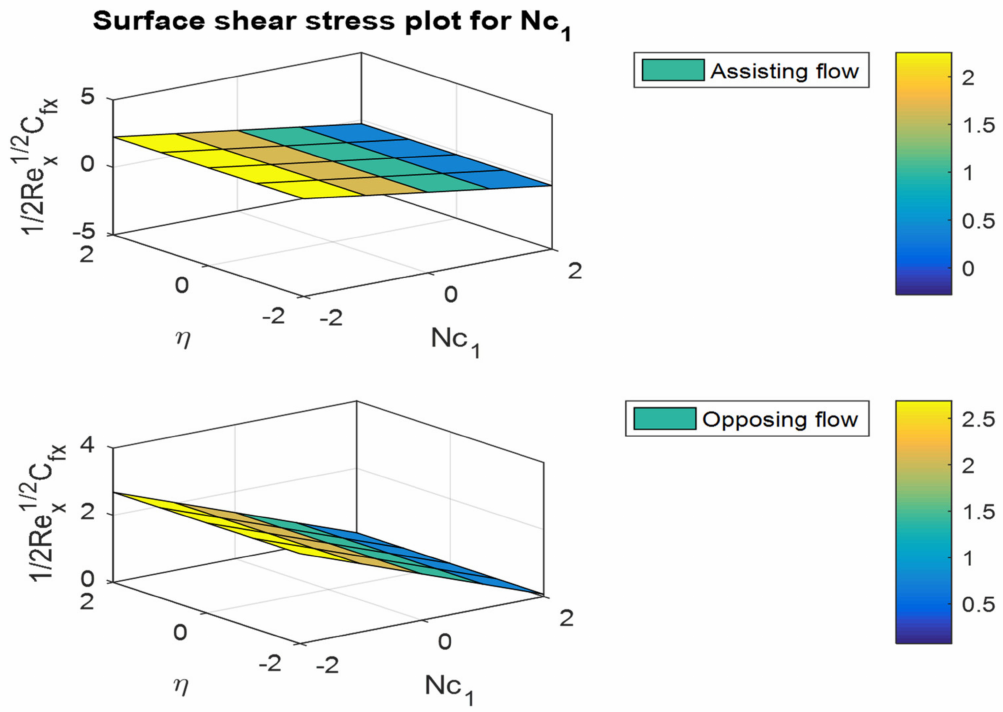
Figure 31. Surface plots for the f (cid:48)(cid:48) ( 0 ) for dissimilar values of Nc 1